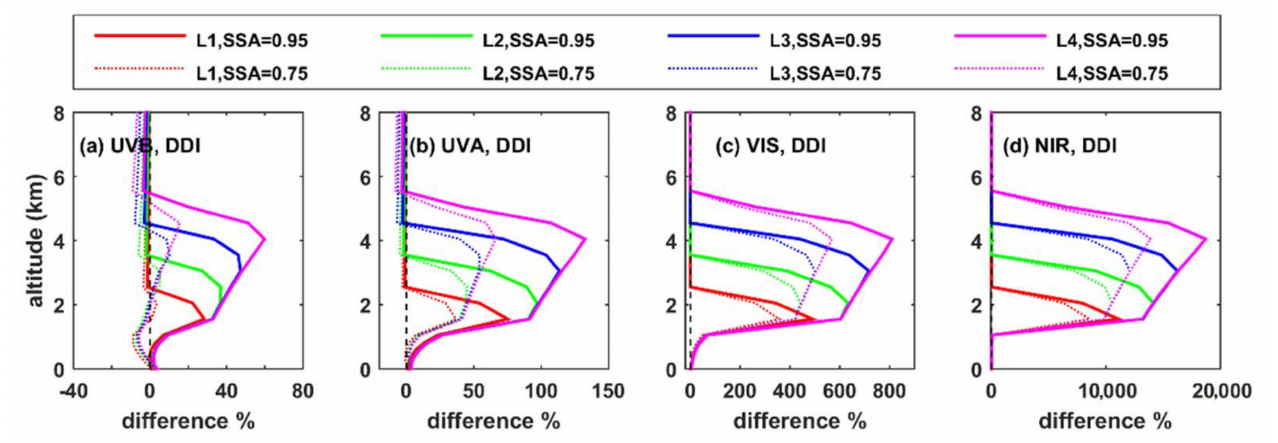
Figure A8. Same as Figure 4, but for SZA = 20 ◦ instead of 60 ◦ . Note that the x-axis scale is different relative to Figure